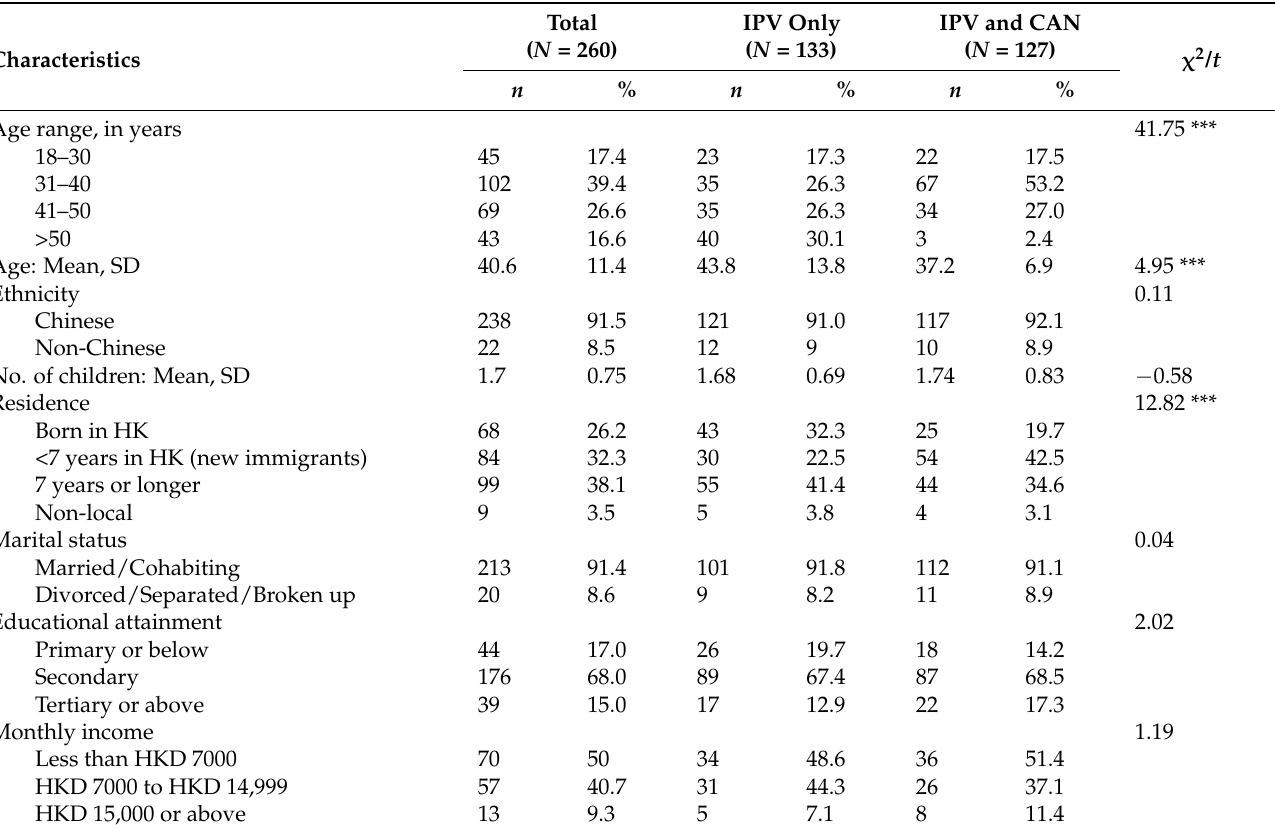
Table 1. Demographic Characteristics of the Battered Women in the Refuge